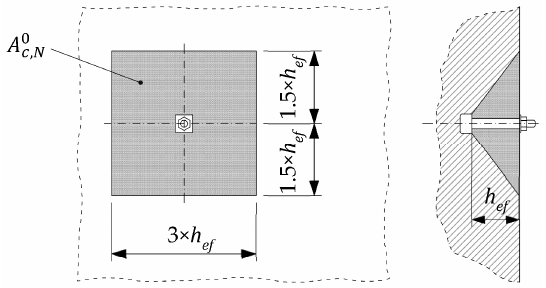
Figure 2. Idealized substrate cone and area A 0 from